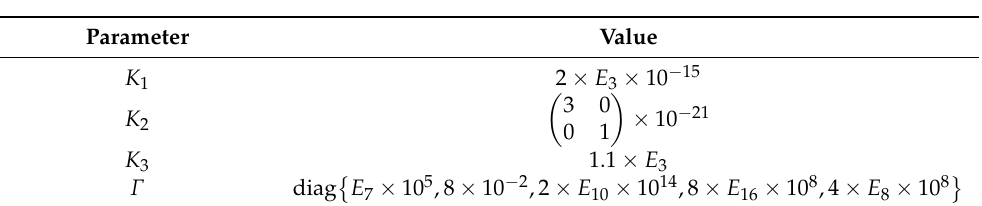
Table 7. Control